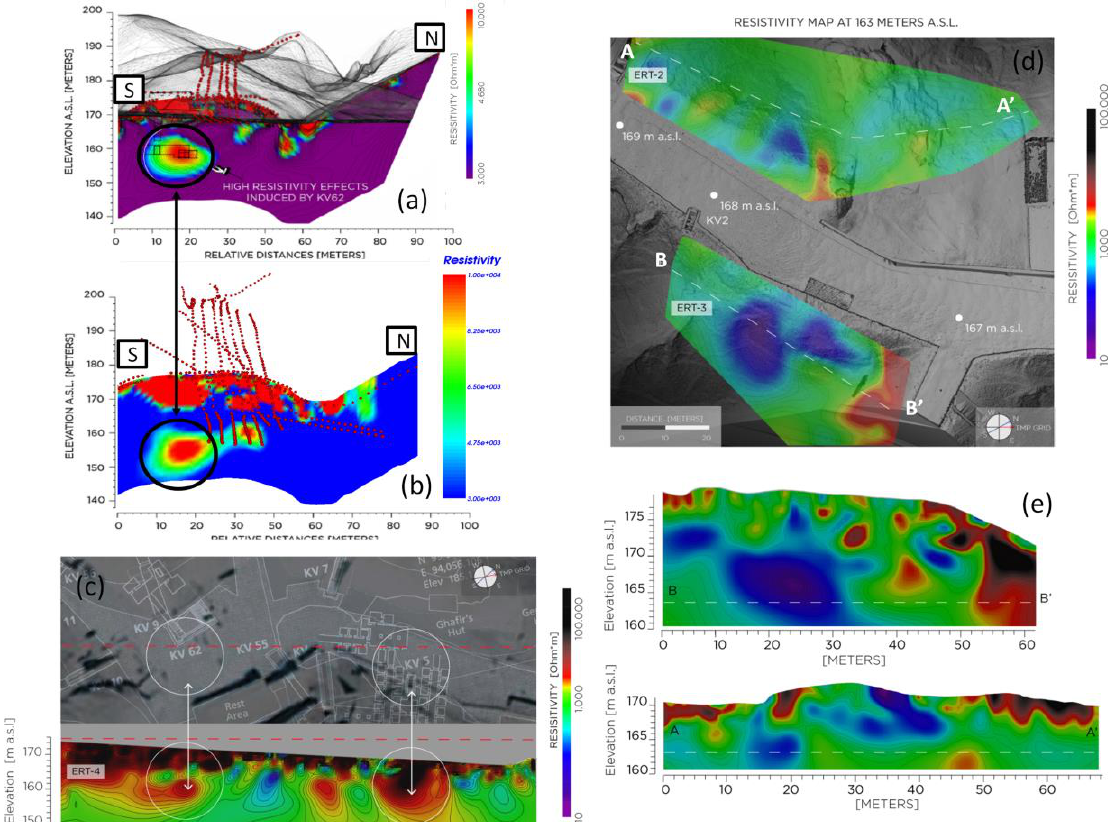
Figure 14. Results from ERT surveys: ( a ) and ( b ) representative cross-section of the 3D model over the KV62 tomb (a from 2017 surveys and b from 2018 surveys); ( c ) the electric resistivity variation reconstructed by ERT-4 and comparison with known voids. The electric resistivity variation reconstructed by ERT-2 and -3 shown by representative maps ( d ) and their associated cross-sections ( e ). Dashed white lines show where each map and its vertical section intersect.